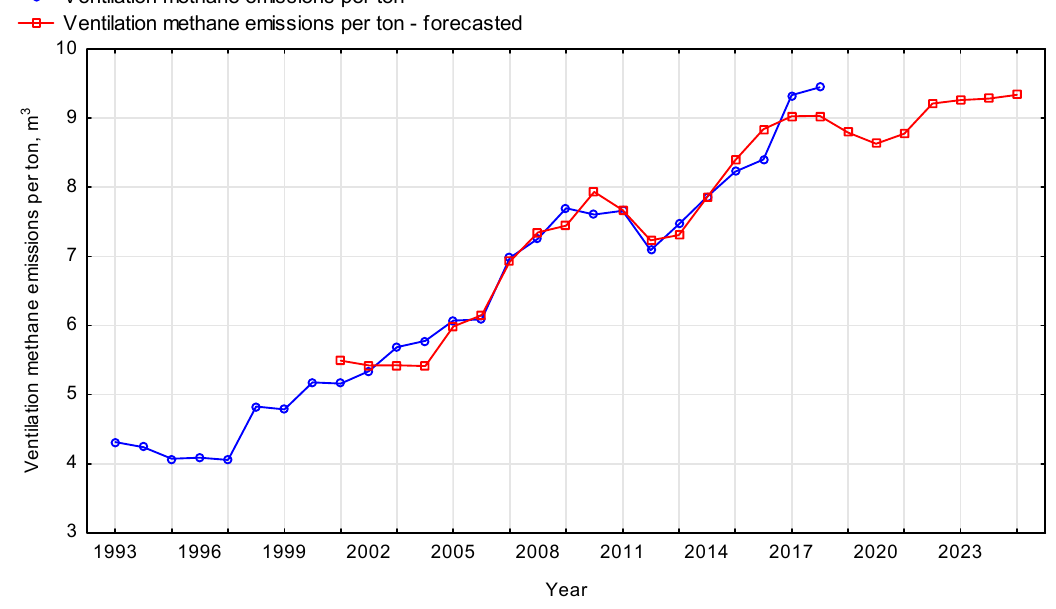
Figure 16. Actual and predicted amount of ventilation methane emissions into the atmosphere per ton of extracted coal.